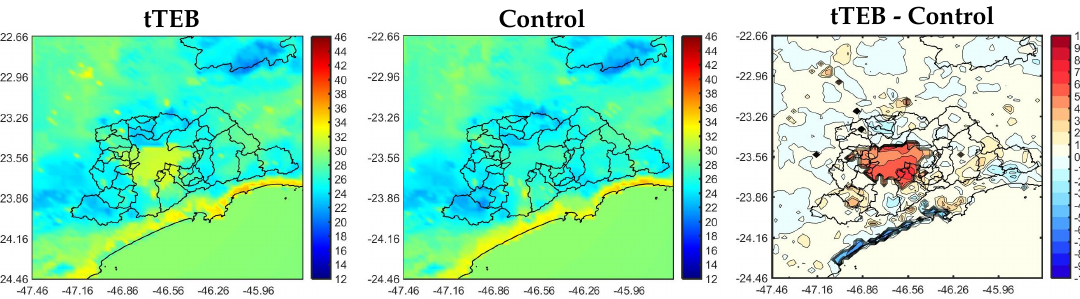
Figure 10. Mean soil surface temperature ( ◦ C) between 00 UTC (21 LT) of 12 January 2015 to 00 UTC (21 LT) of 13 January 2015. The figure shows the results of the tTEB experiment (first column), the control experiment (second column) and the differences between both experiments (third